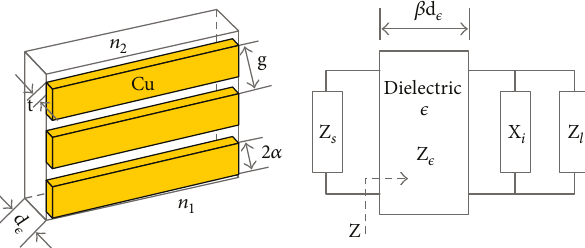
Figure 5: The structure of grid printed on the dielectric substrate and its equivalent transmission line